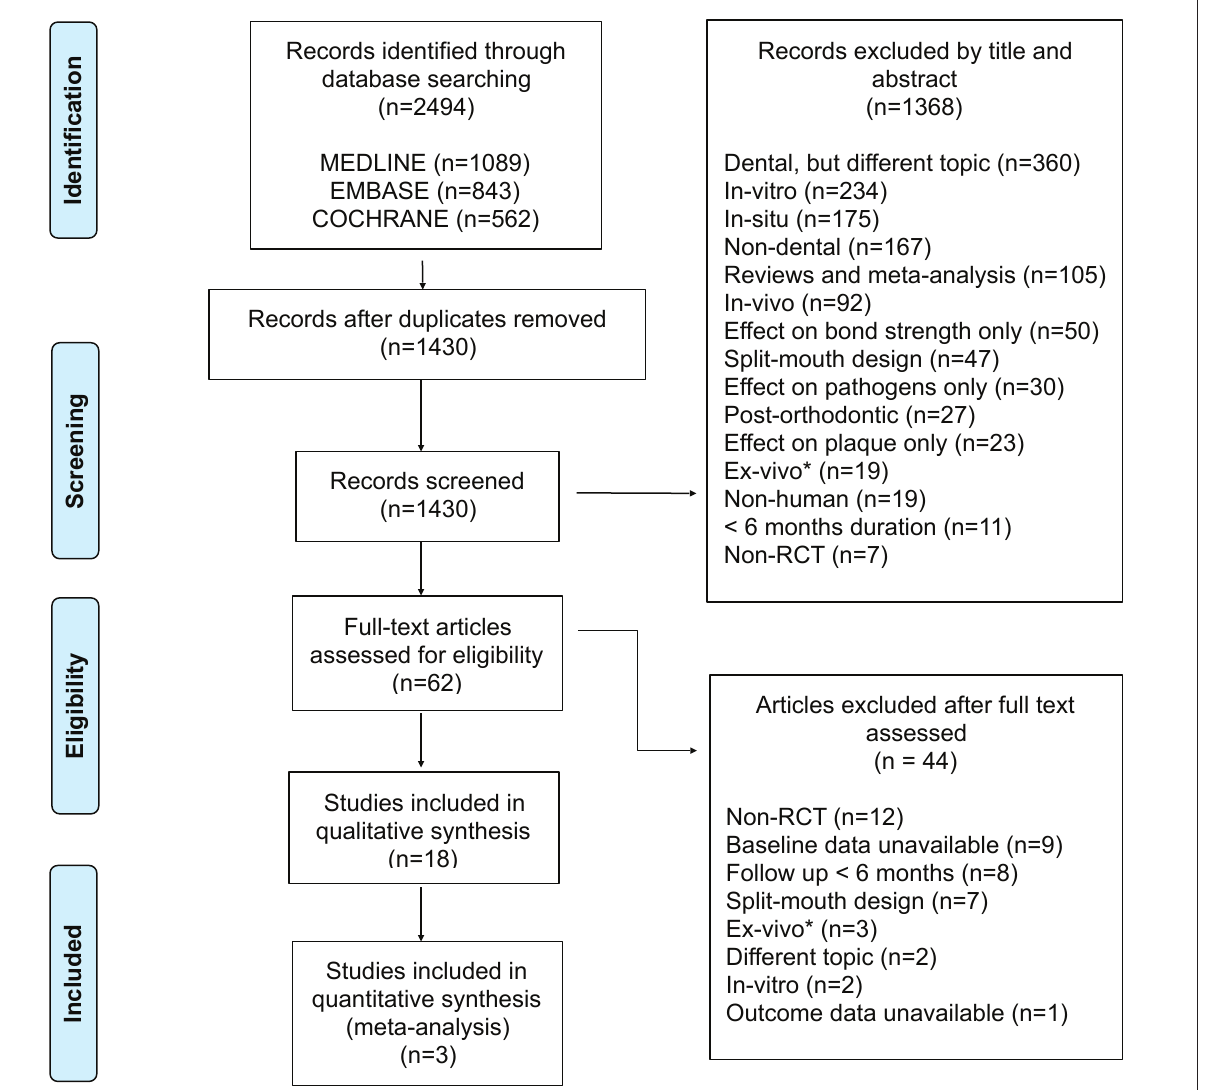
Figure 1. PRISMA flowchart presenting the study selection and identification